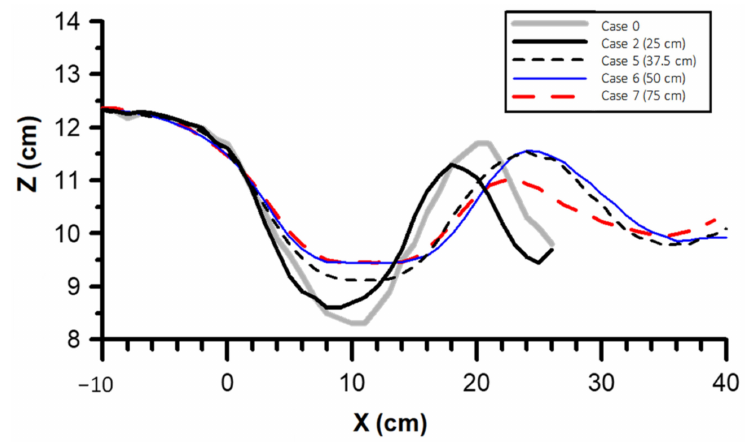
Figure 17. Response of water surface due to different strip